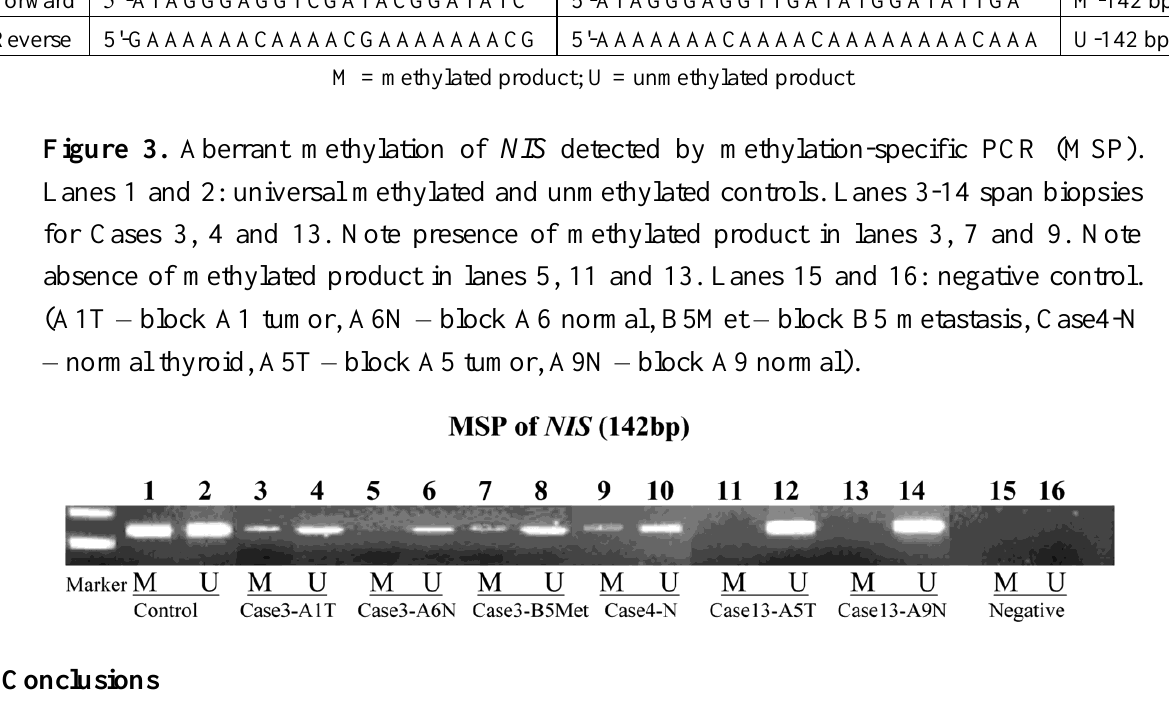
Table 1: Methylation-Specific PCR (MSP) Primer Sequences for NIS gene. Methylation Specific Primers